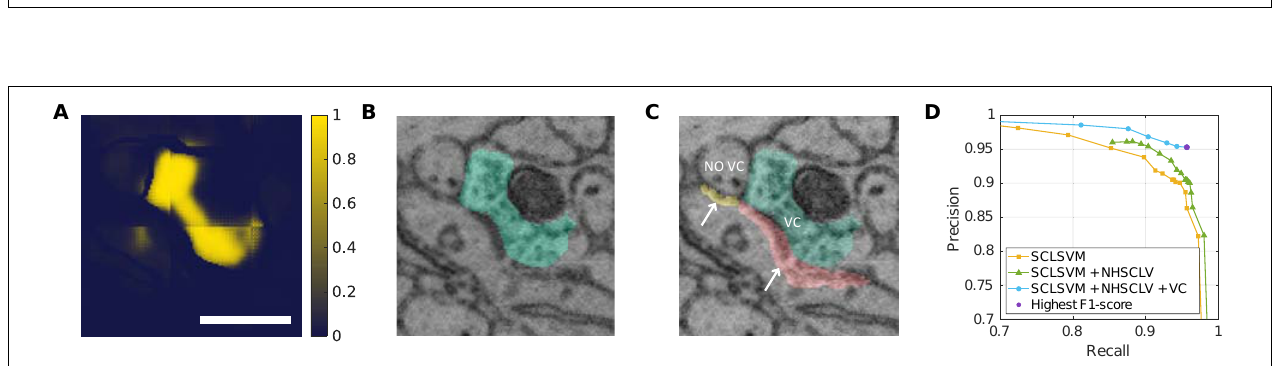
FIGURE 4 | Synapse candidates are the contacts with high SC likelihood. (A) Two contacts are shown (first panel), one between Neurons 1 and 2 (red); one between Neurons 2 and 3 (blue). The SC-Net produces the SC-likelihood map of all the voxels (middle panel). The likelihood values only for the voxels belonging to each contact are collected (right panel) using the contacts as a mask. A scale bar: 600 nm, 50 voxels. (B) The distributions of the SC-likelihood values for the two contacts are shown together with 3 percentiles. The contact that is likely to be synaptic (1–2) has narrowly peaked distribution toward high values (red histogram). The 95th percentile (a red dash-dotted line) assesses the bias toward high values, and the (85th–99th) percentile range (a red dashed line) assesses the width of the peak. (C) When the two percentile measures are scatter plotted, synaptic contacts (a red circle) and non-synaptic contacts (a blue cross) from the training sets loosely segregate with a fuzzy boundary. A support vector machine (SVM; SC-likelihood SVM; SCLSVM) was trained to draw a decision boundary. The two regions separated by the boundary are colored with green (positive) and pink (negative) backgrounds, respectively. The contacts that have 400 or more voxels with 0.9 or higher SC likelihood are also considered as synapse candidates (number of high-SC-likelihood voxels; NHSCLV). The purple squares indicate the contacts that transit from negative to positive by this. (D) The histograms of the SVM scores of the synapses and non-synapses in the test set are shown. The dashed vertical line represents the usual decision boundary, a zero-SVM score. However, we wanted to accept a few false positives near the boundary to enlarge the pool of synapse candidates. (E) The PR curves for varying SVM thresholds are plotted, for the cases when only the SCLSVM is used and when both the SCLSVM and NHSCLV are used (see section “Finding Synapse Candidates Using SC Likelihood”). The F2-score, which measures the false-positive errors permissively, is the highest when the SVM threshold is –0.2 (a purple triangle). The SVM threshold for synapse candidate selection is decided to be –0.2.